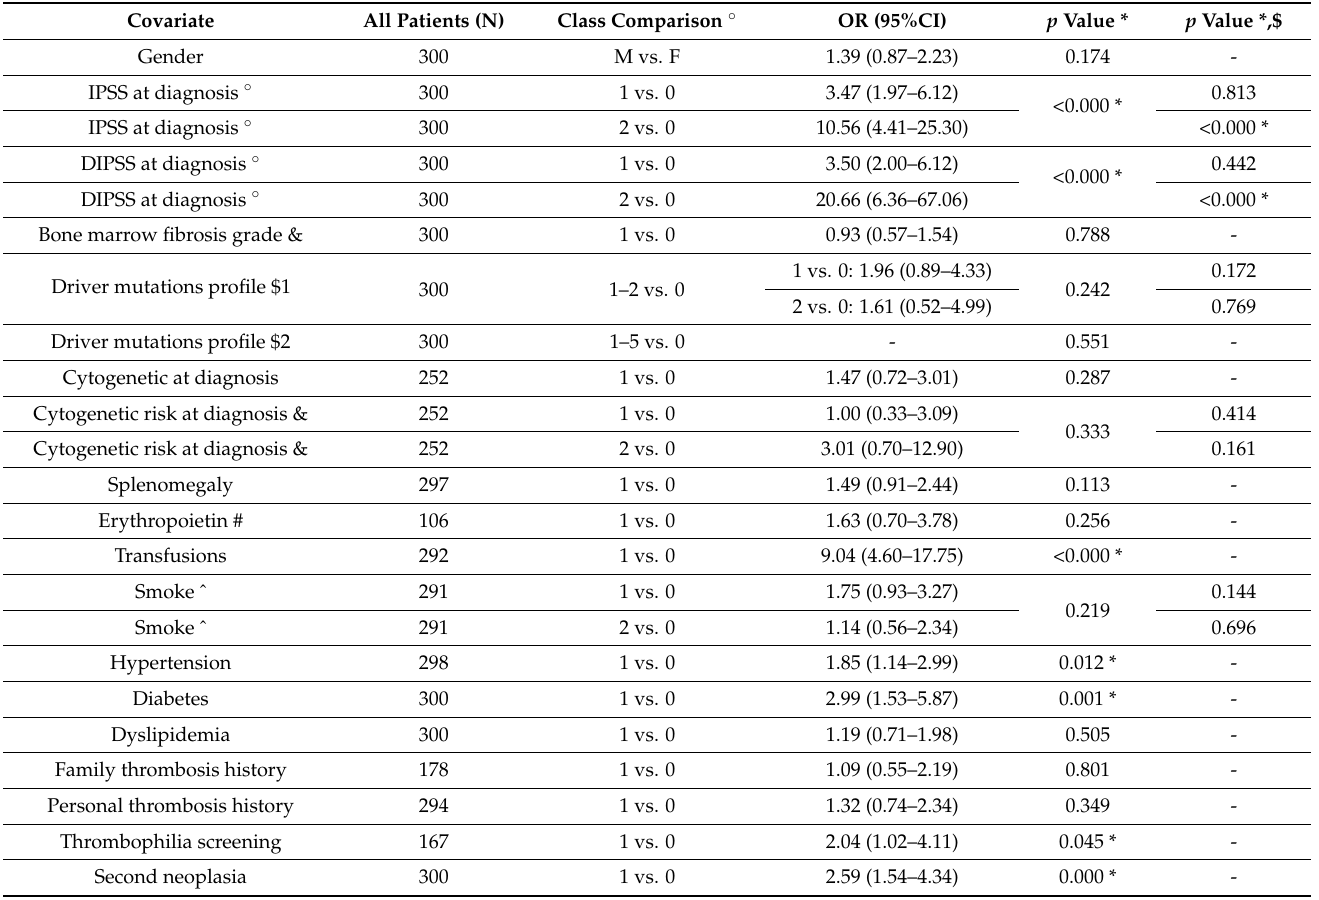
Table 3. Univariable analysis considering the association between covariates and patients’ outcome (occurrence of death, only).